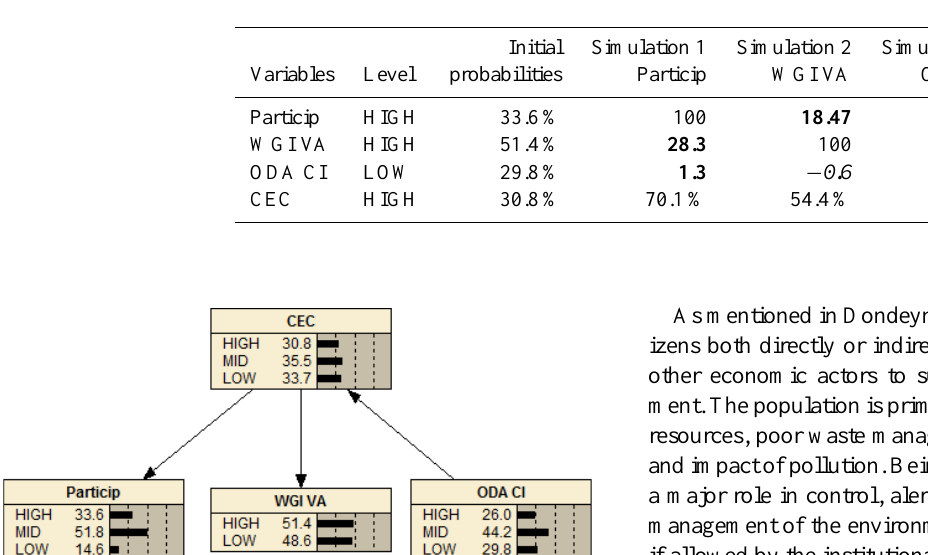
Table 5. Thematic model, CEC simulations. In bold, positive variations and in italic, negative variations of probabilities.